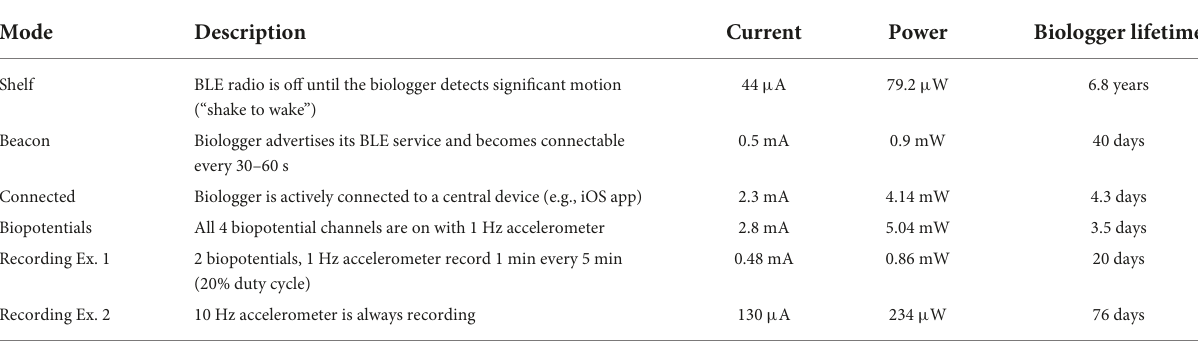
TABLE 2 Operating modes and power